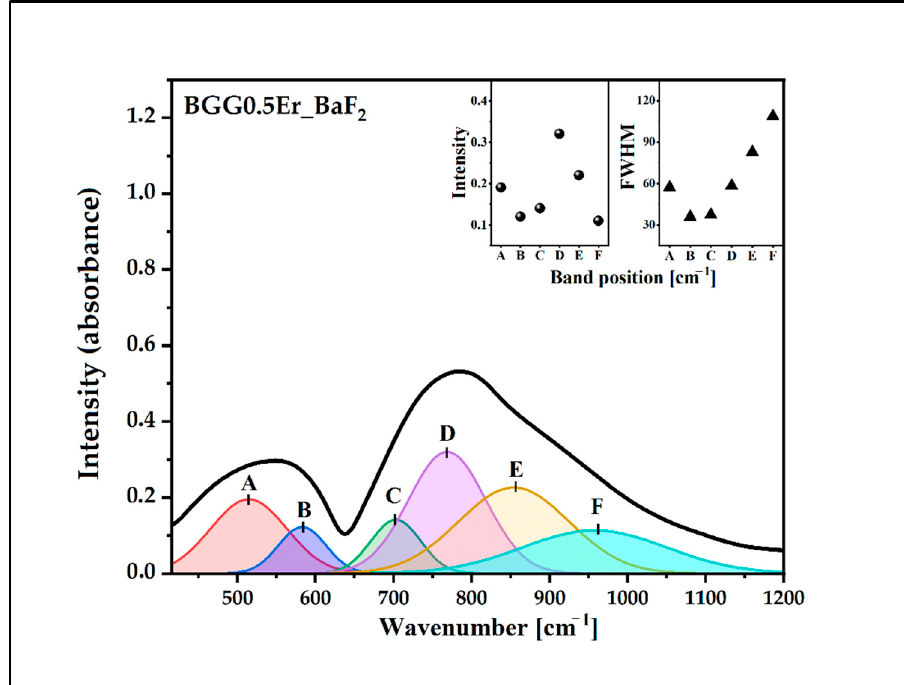
Figure 6. Deconvoluted IR spectrum of BGG0.5Er_BaF 2 glass.